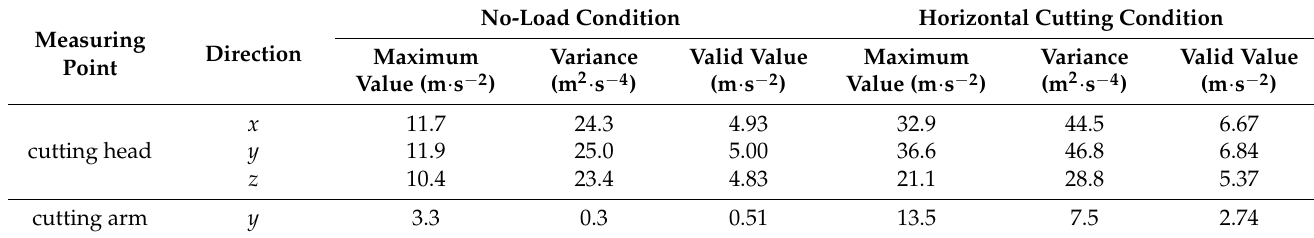
Table 2. The peak vibration acceleration data in the time domain measured in the